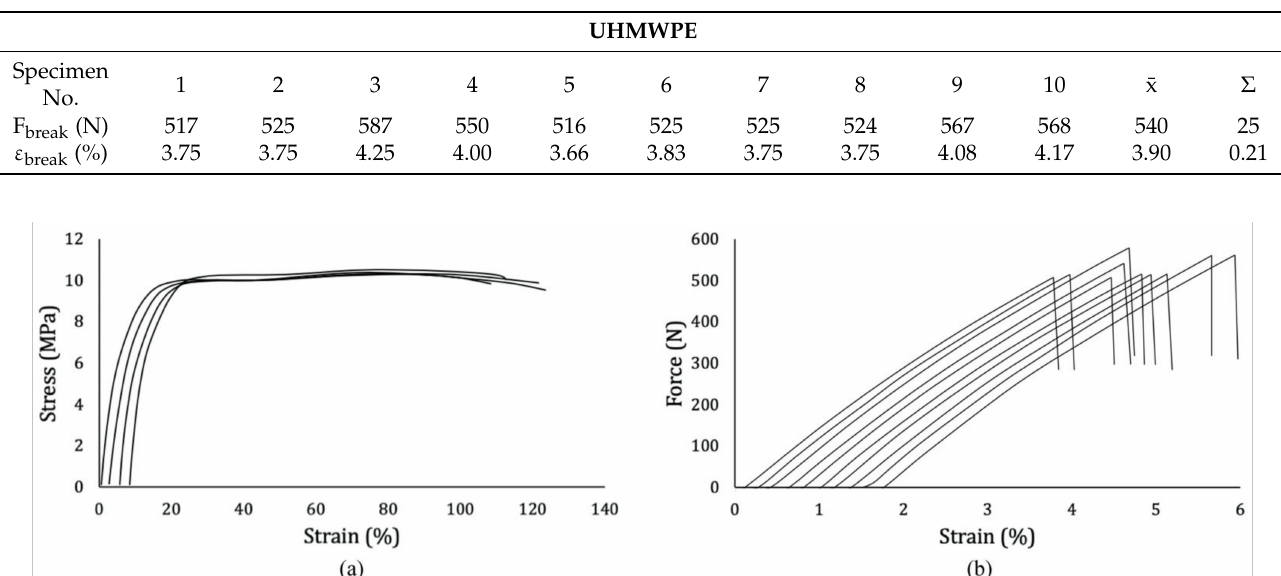
Table 4. Tensile results of UHMWPE.